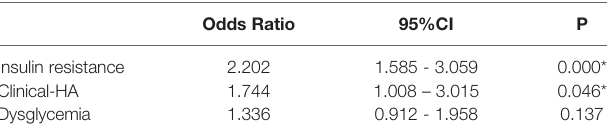
TABLE 3B | Association between insulin resistance, clinical hyperandrogenism, dysglycemia, and dyslipidemia in PCOS women. Odds Ratio 95%CI P Insulin resistance